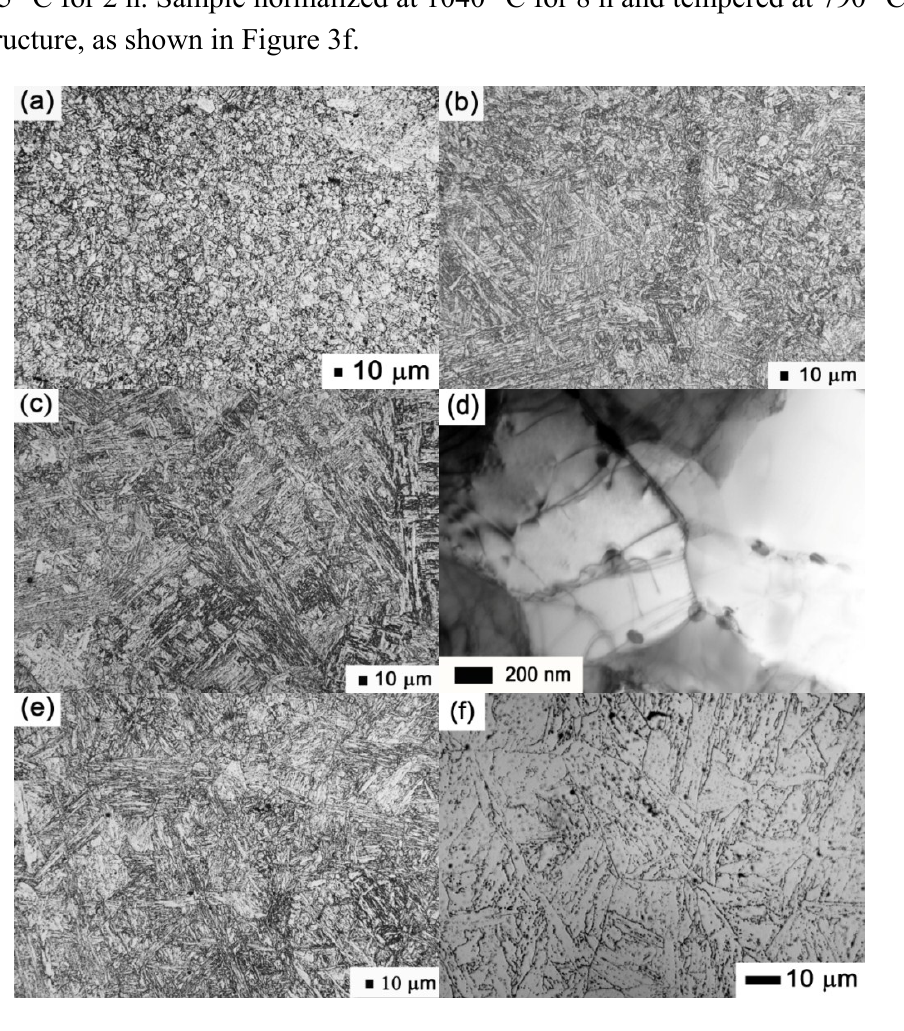
Figure 3. Tempered optical micrographs: ( a ) normalized at 1040 °C for 2 h and tempered at 690 °C for 2 h; ( b ) normalized at 1040 °C for 2 h and tempered at 745 °C for 8 h; ( c ) normalized at 1040 °C for 2 h and tempered at 790 °C for 2 h; ( d ) TEM micrograph of sample normalized at 1040 °C for 2 h and tempered at 790 °C for 2 h; optical micrographs ( e ) normalized at 1040 °C for 4 h and tempered at 725 °C for 2 h; and ( f ) normalized at 1040 °C for 8 h and tempered at 790 °C for 20